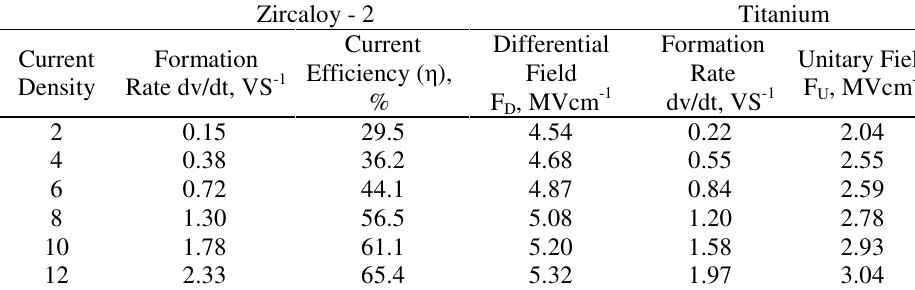
Table 5. Data on the anodisation of Zr-2 and Ti in 0.1 M sodium methoxide. Zircaloy - 2